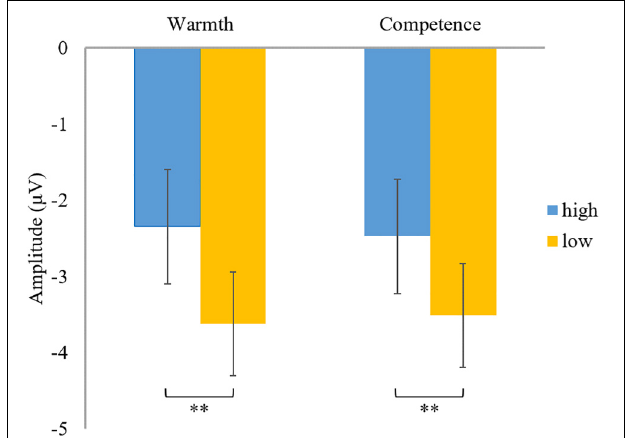
FIGURE 4 | Descriptive statistics and contrasts for the N400 component ( ∗∗ p ≤ 0.01).